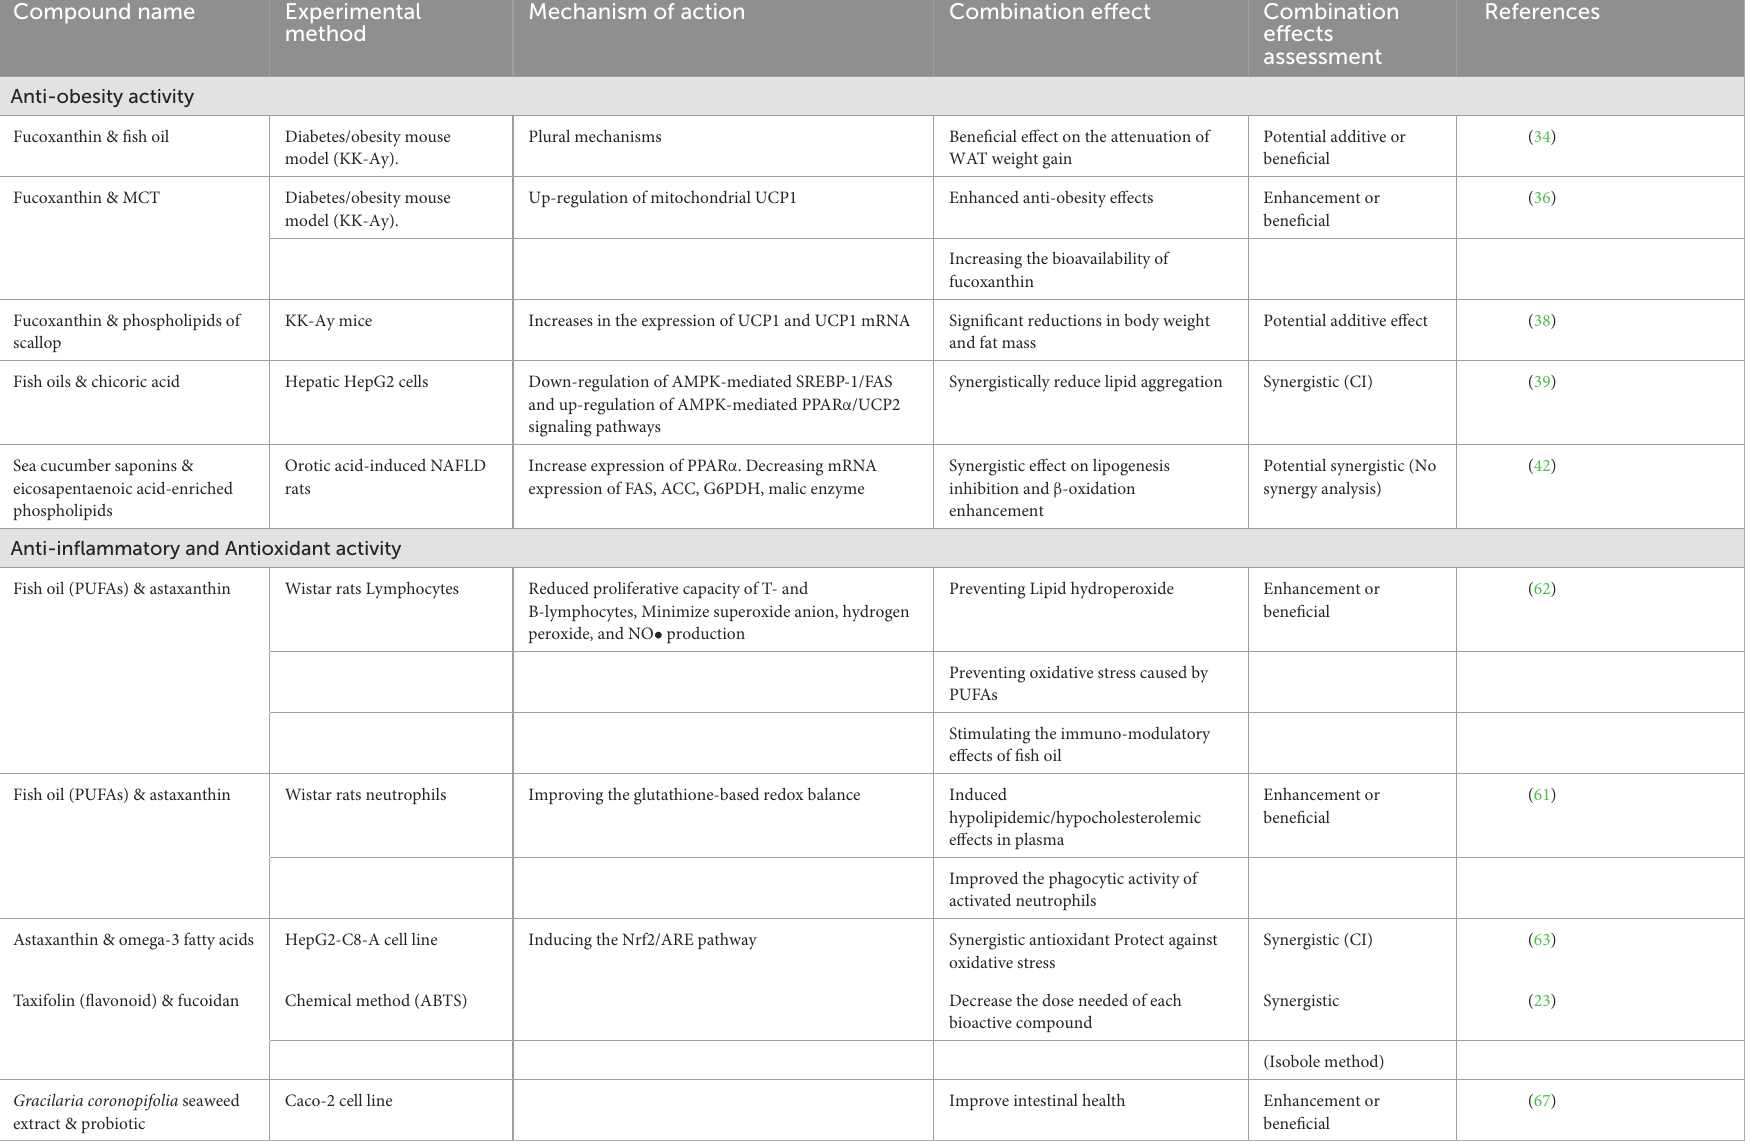
TABLE 4 List of combination of marine bioactive